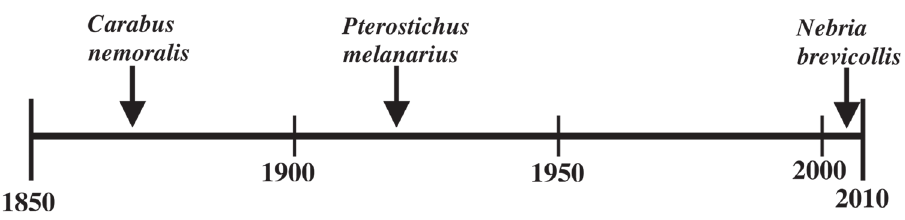
Figure 1. Approximate timeline of detections of Carabus nemoralis, Pterostichus melanarius, and Nebria brevicollis in North America.